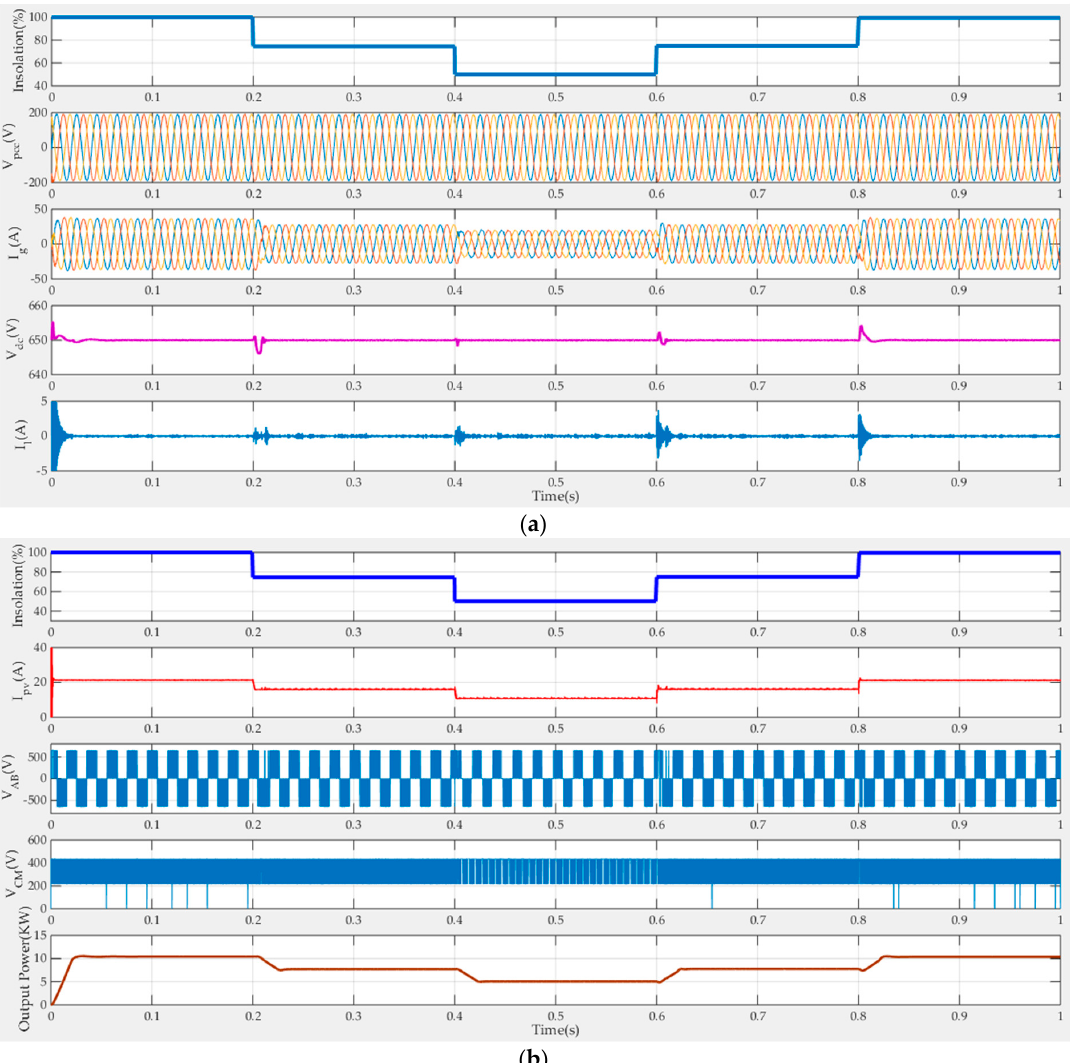
Figure 7. The response of the proposed system to step variations in the isolation level, @